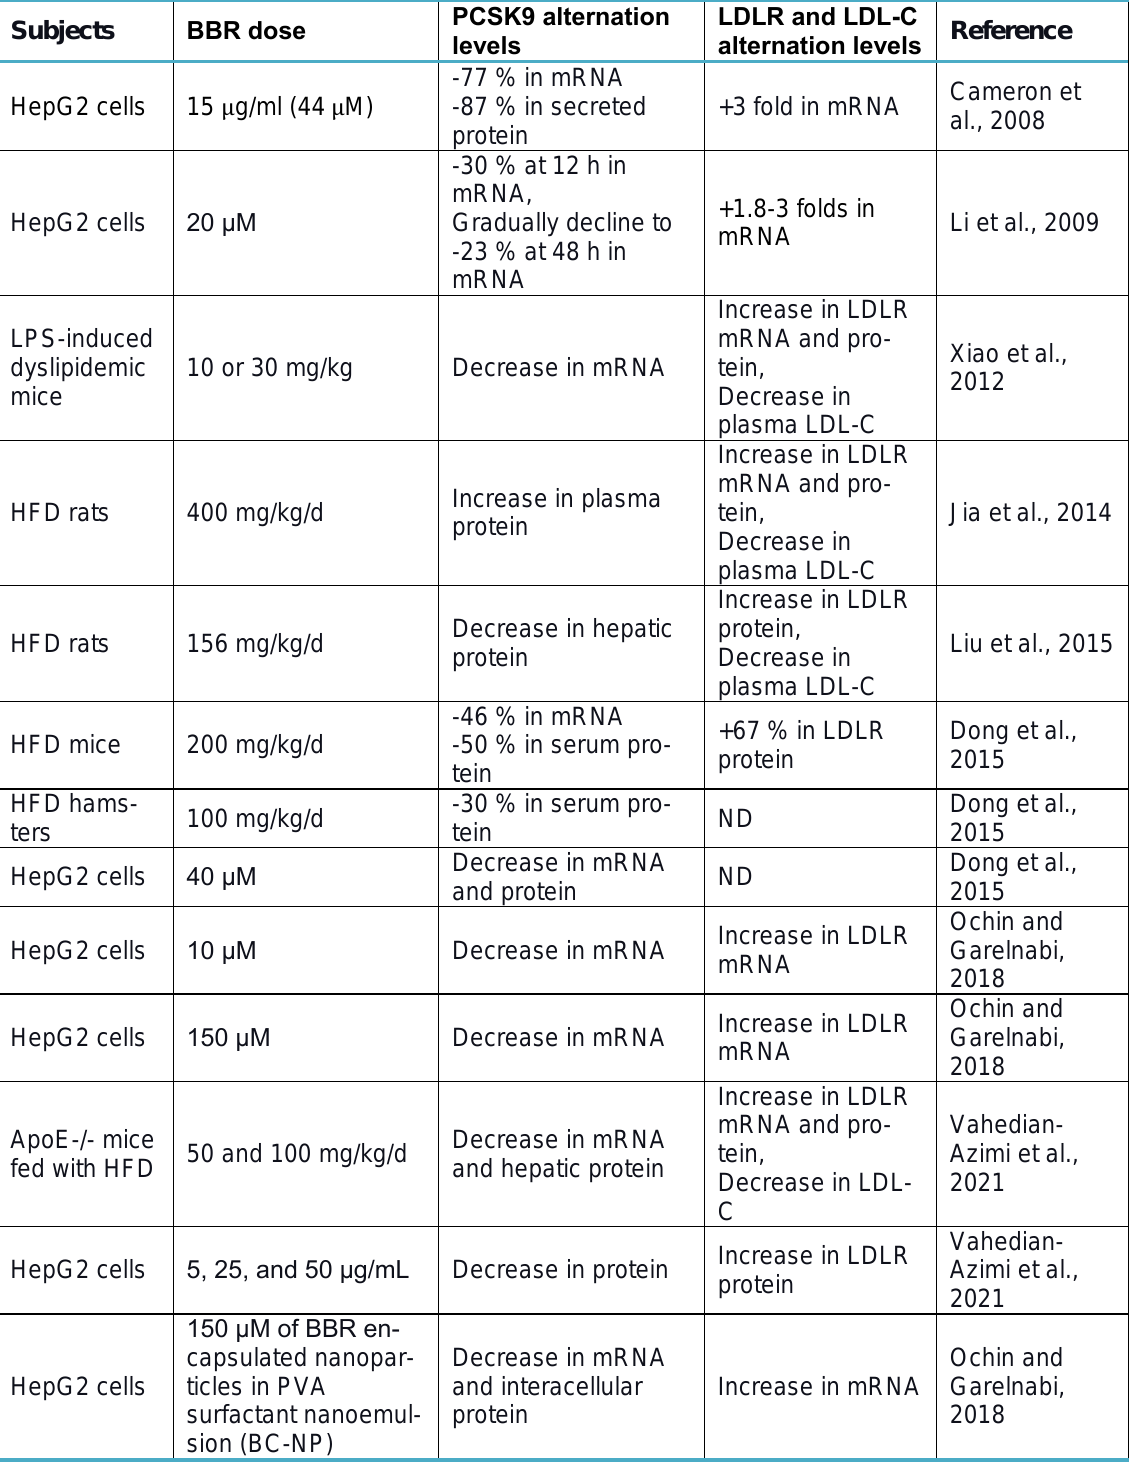
Table 1: Effect of berberine on PCSK9, LDLR, and LDL-C levels in experimental studies